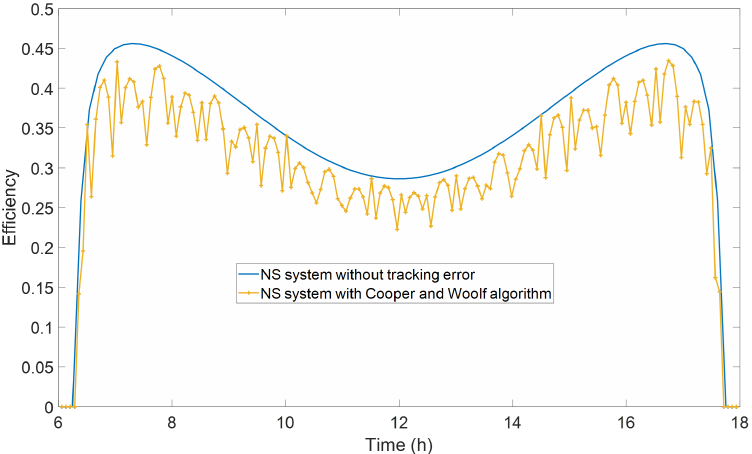
Figure 4. Efficiency comparison of two parabolic trough system with tracking error generated by the Cooper and Woolf method and without tracking error condition, respectively, under NS tracking system at the spring equinox; NS: north–south axis tracking